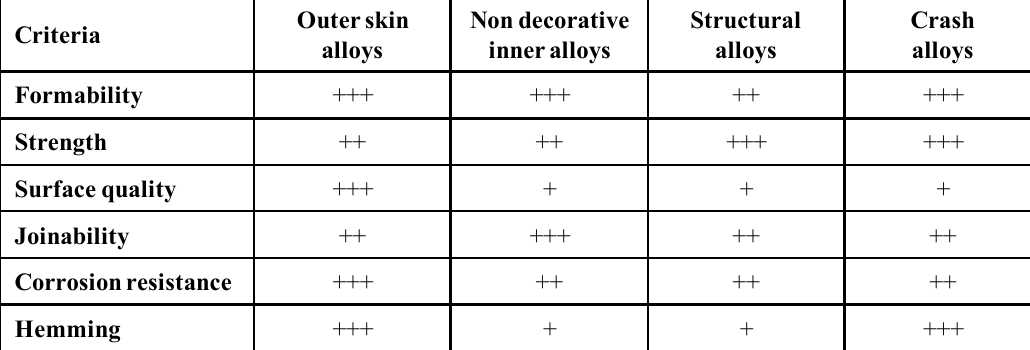
Heat-treatable alloys have the advantage of combining both good formability